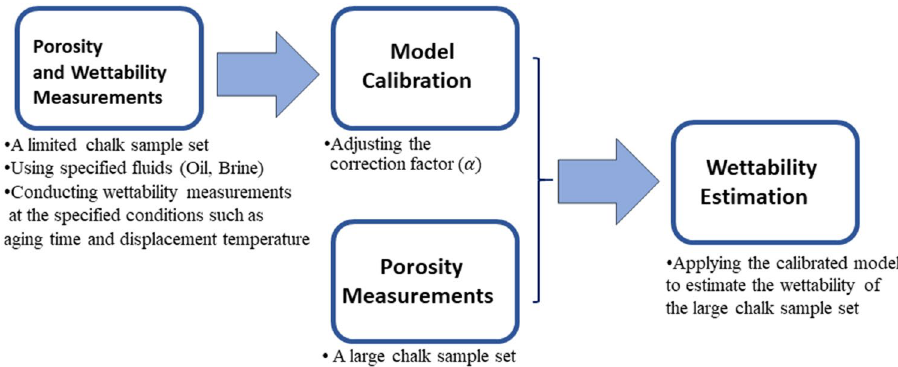
Fig. 2 A schematic general sketch of the